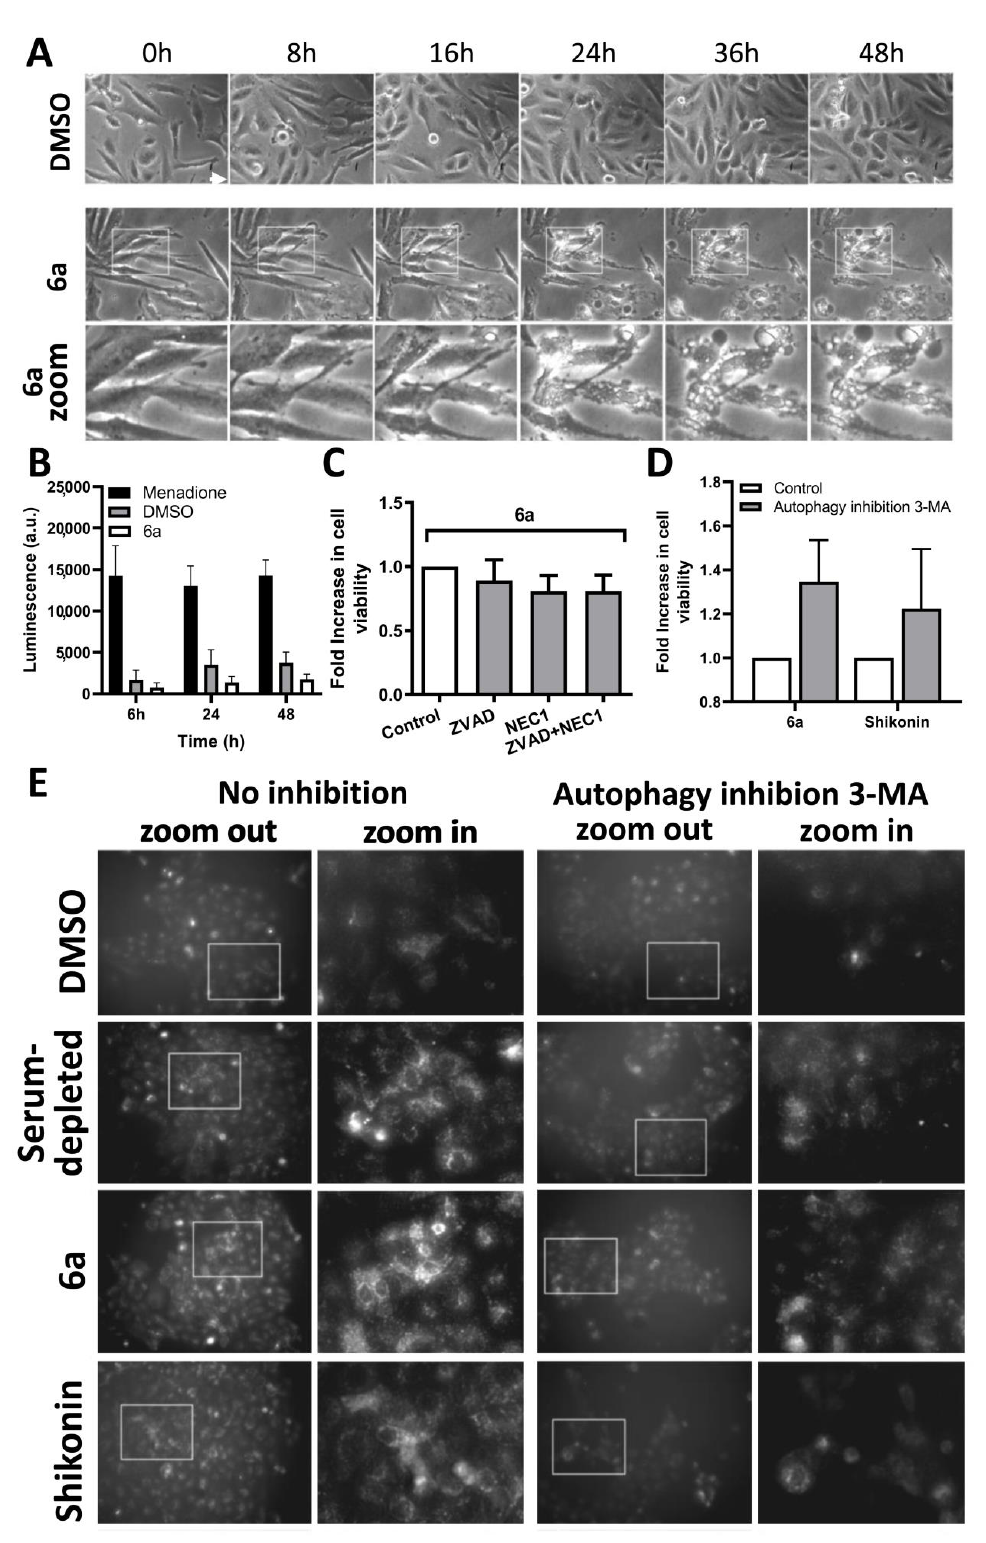
SCC9 cells (Supplementary Figure S2) and induces a low level of PI positive cells indicative of necrosis (Figure 4A).